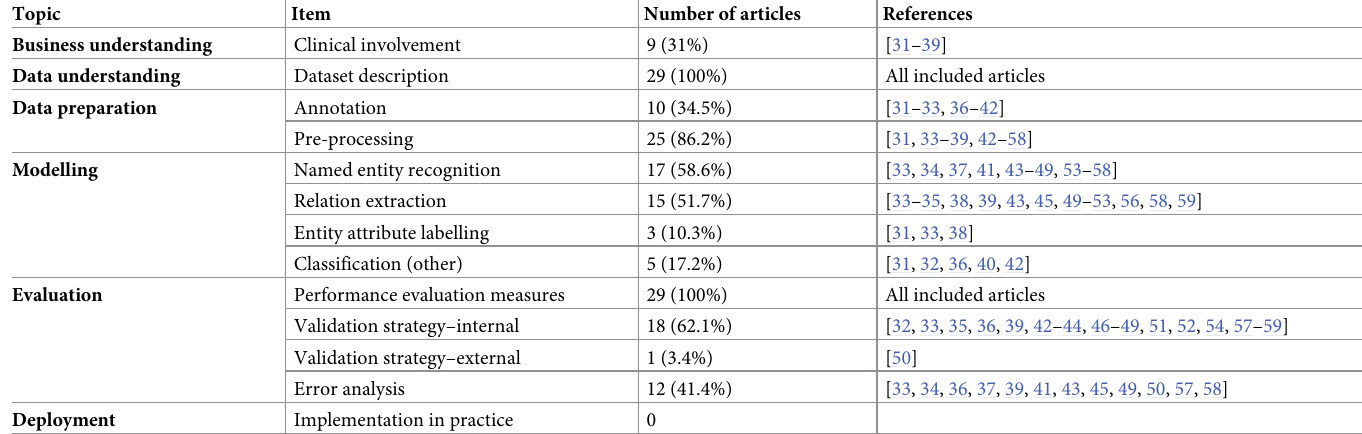
Table 2. Operational assessment of the included articles against the proposed